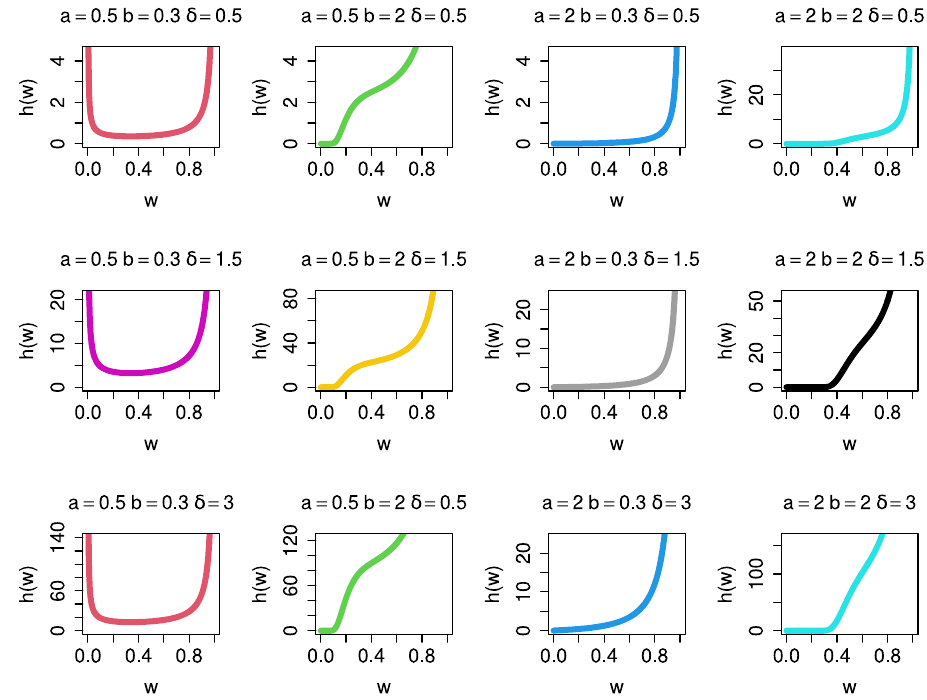
Figure 2. Plots of various HF shapes of the UPBXD for different parameter values. In Figure 1, the PDF graphs for various parameter combinations display a variety of shapes, such as ( a = 2, b = 2) symmetric normal, ( a = 0.5, b = 0.3) U ‐ shaped, ( a = 0.5, b = 2) right ‐ skewed, ( a = 2, b = 0.3) J ‐ shaped, and ( a = 2, b = 2) normal tapered. In Figure 2, the UPBXD’s HF shapes in ( a = 0.5, b = 2), ( a = 2 , b = 0.3), and ( a = 2, b = 2) have increasing and J shapes, while ( a = 0.5, b = 0.3) has a bathtub shape. The parameter is responsible for the bathtub shapes given that the other two parameters ( a and b ) are less than one. The parameter is responsible for the J shapes where a >1 and b <1. By inverting (5), we can get the quantile function (QF) of the UPBXD, which looks like this: (8) where q is the uniform random variables. The fi rst, median, and third quantiles are pro ‐ duced by se tt ing q = 0.25, 0.5, and 0.75 in (8). It is simple to simulate the random variable of the UPBXD from (8).